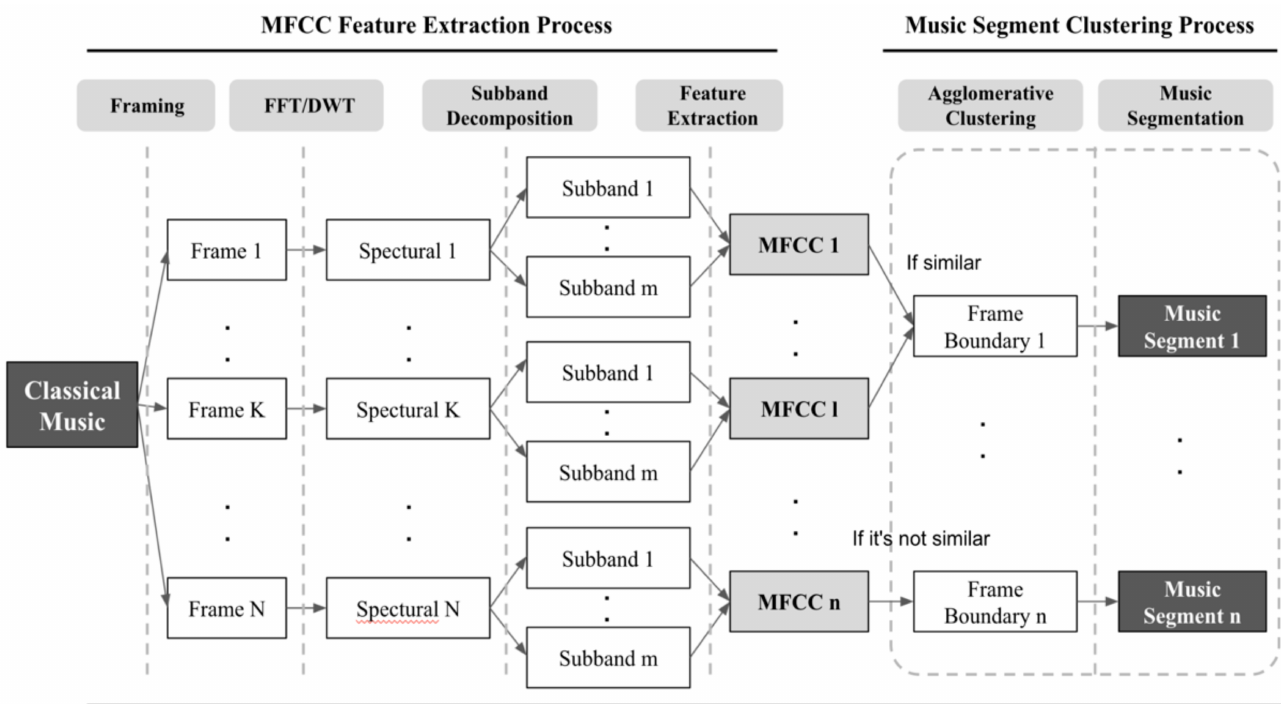
Figure 4. Dataset B Production Process by MFCC Feature Extraction and Music Segment